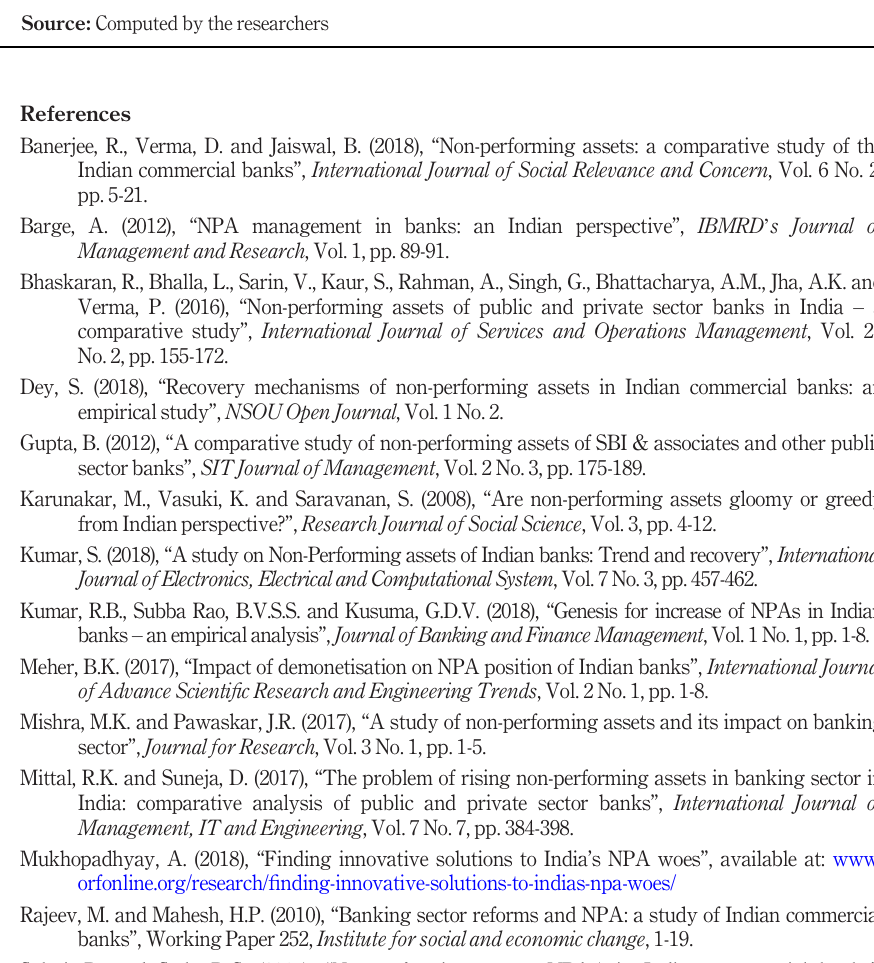
Table VI. Nationalised banks